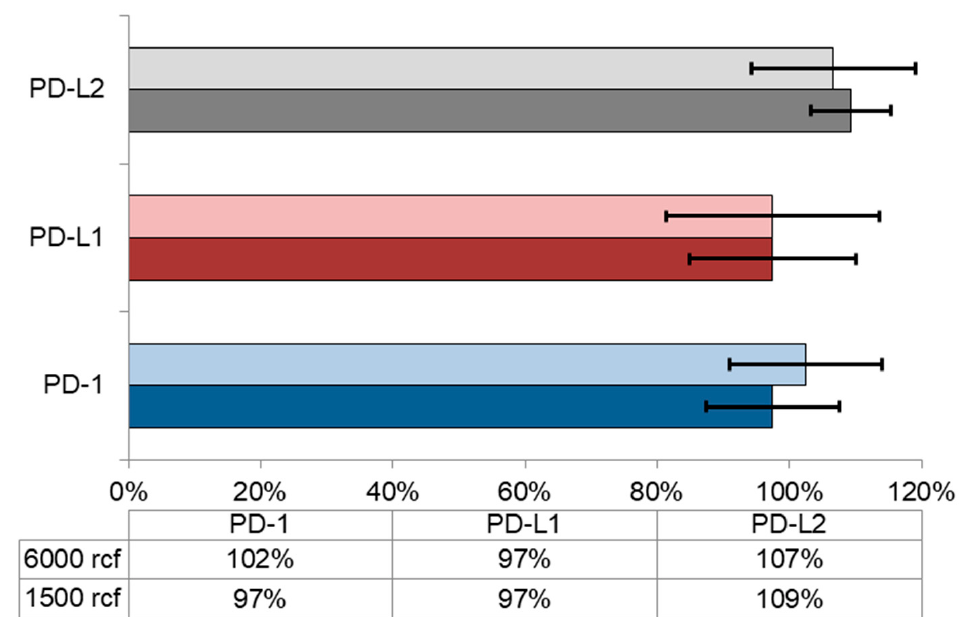
Figure 2. Influence of the variation of centrifugation speed. Mean recoveries obtained after a 10 min centrifugation at 1500 rcf (dark) and 6000 rcf (light) are compared with the reference speed of 3000 rcf in a bar chart. Coefficients of correlation are depicted in the form of error bars. Table 1. Mean recoveries calculated from heparin plasma in course of the short-term stability